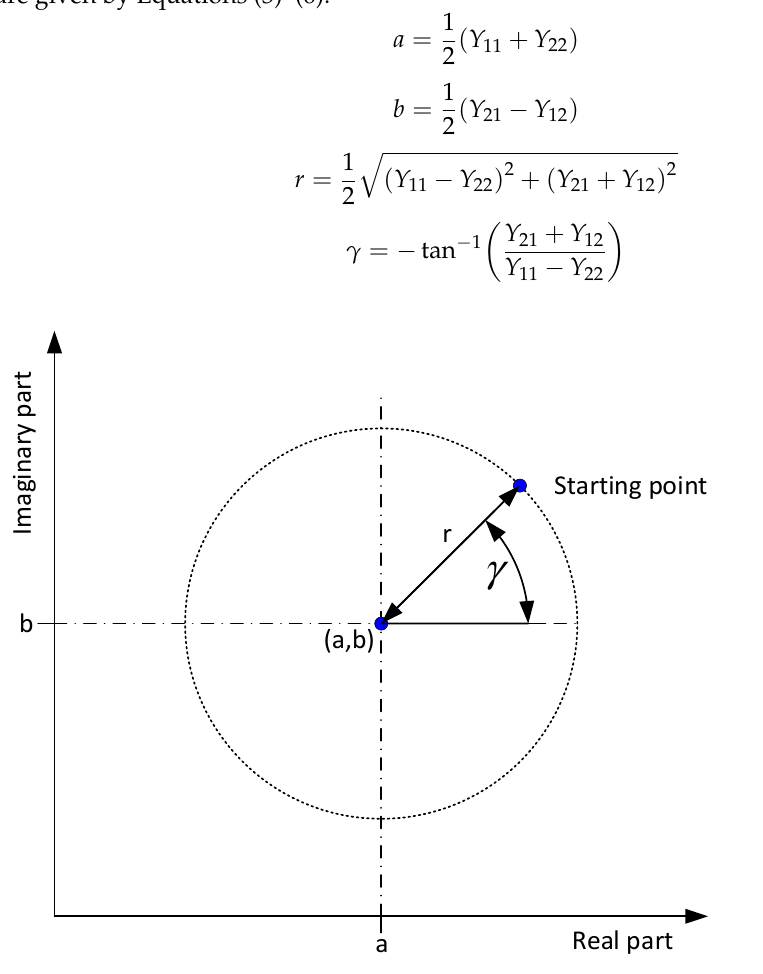
In the complex (real–imaginary) plane, the 2 × 2 tensor expressing the phase depen- dency is a circular locus, as depicted in Figure 4. The loci points depend on the phase of the harmonic voltage relative to the fundamental voltage. The main features a , b , r , and γ are given by Equations (3)–(6).